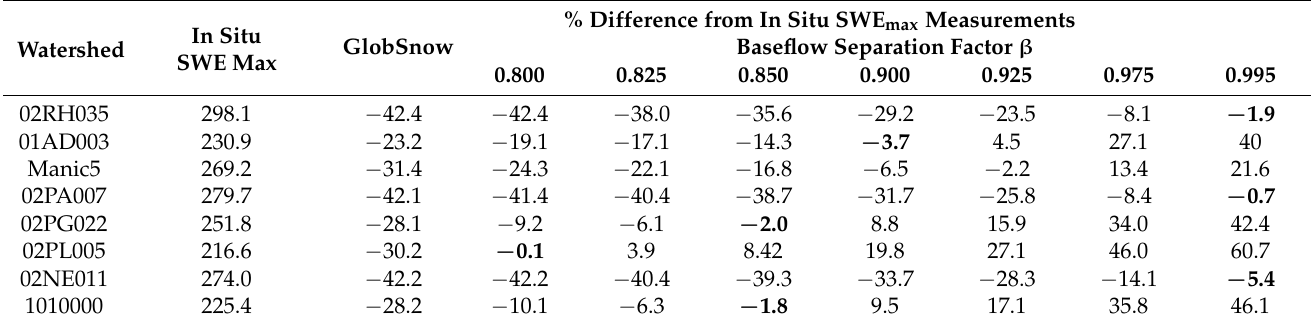
Table 5. Performance of the WSC approach to replicate the maximum measured SWE for the studied watersheds as a function of baseflow separation factor β .